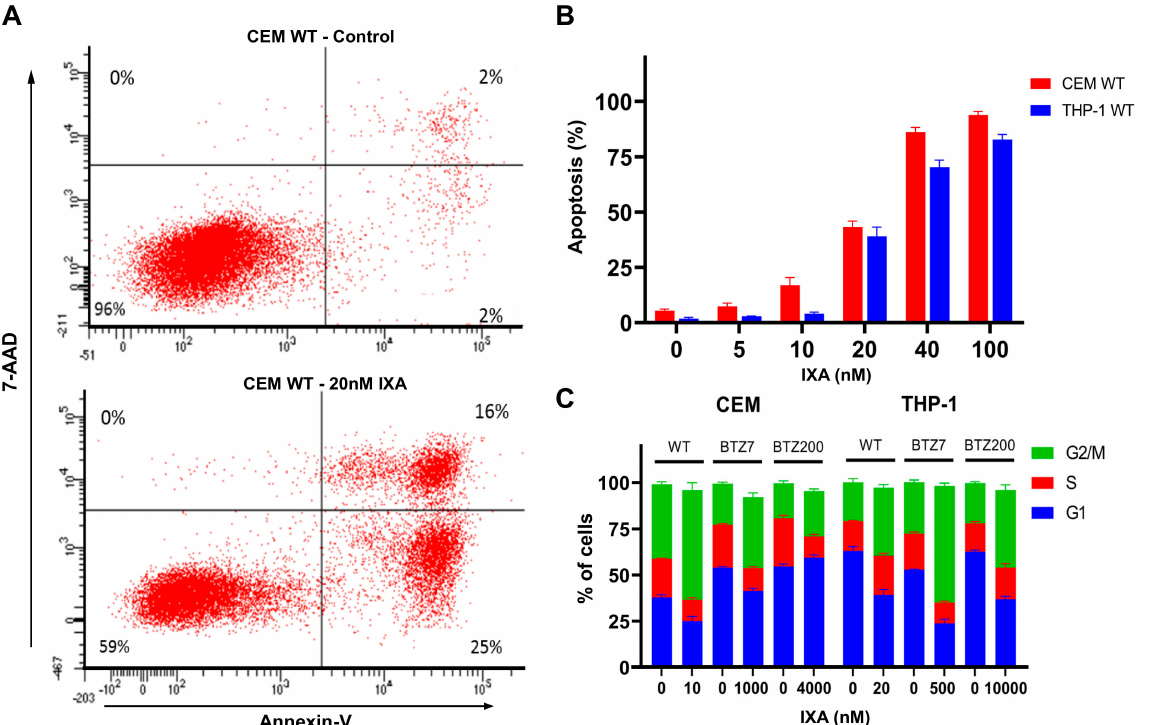
Figure 3. IXA-induced apoptosis and effects on cell cycle in (BTZ-resistant) leukemia cells. ( A ) Representative flow cytometry image of apoptosis induction (Annexin-V and 7-amino-actinomycin D (7-AAD) staining) for control CEM/WT cells (upper left) and CEM/WT cells exposed for 24 h to 20 nM IXA (lower left). ( B ) Quantification of apoptosis induction in CEM/WT and THP-1 cells exposed for 24 h to 0–100 nM IXA. Results show percentages of apoptotic cells ± SEM of three separate experiments. ( C ) Cell cycle analysis profile (propidium iodide staining) of CEM/WT and THP-1/WT cells and their low/high BTZ-resistant sublines. Cells were exposed for 24 h to the indicated concentrations of IXA. Results: Distribution of cells over G0, S, and G2/M phases is depicted as the mean ± SEM of three separate